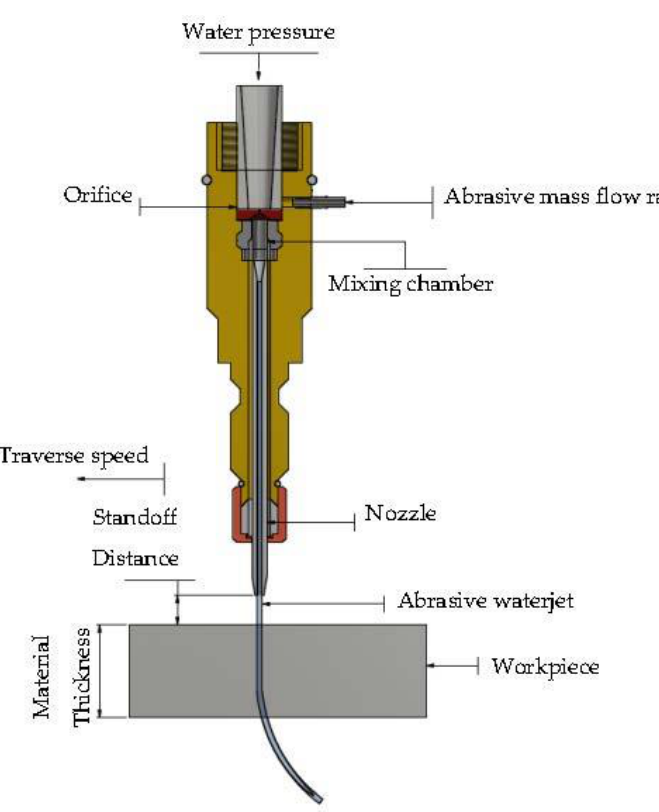
Figure 1. Schematic representation of AWJM cutting.